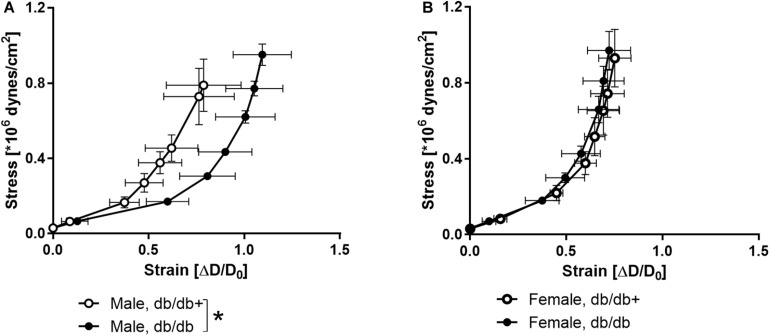
Stress-strain curves in coronary arteries. Strain measured as change in diameter (ΔD) over initial vessel diameter (D0) plotted against stress in coronary arteries from (A) db/db+ and db/db male mice and (B) db/db+ and db/db female mice. *P < 0.05, db/db (n = 6) versus db/db+ controls (n = 6).